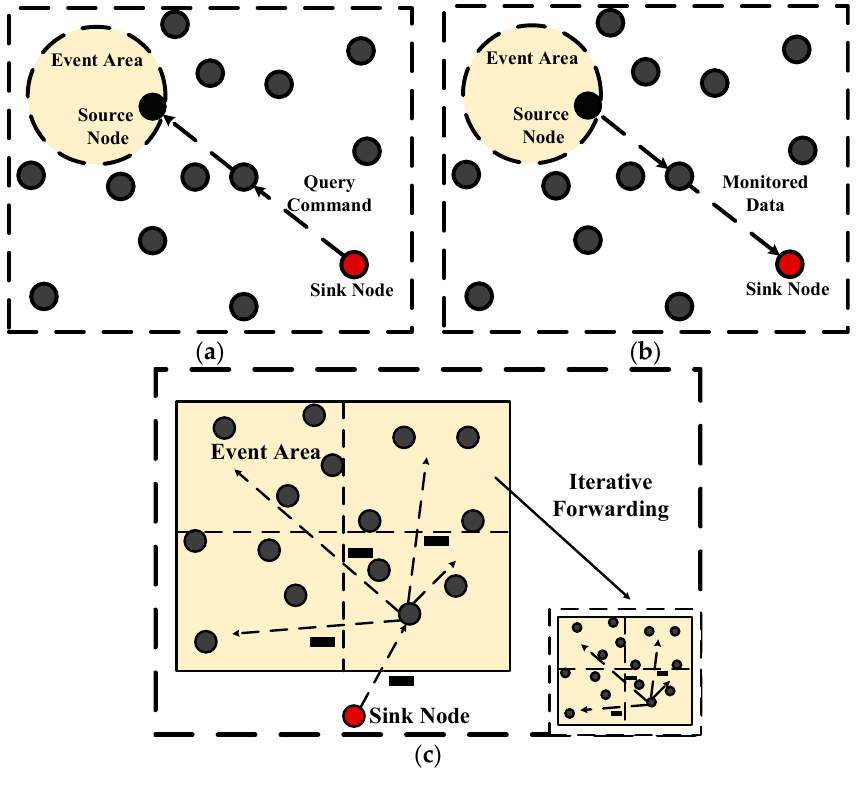
Figure 1. A schematic of Geographic and Energy Aware Routing (GEAR) protocol. ( a ) Process of sending a query command; ( b ) The required data is transmitted to the sink node along the reverse path; ( c ) The query iteration in event area.